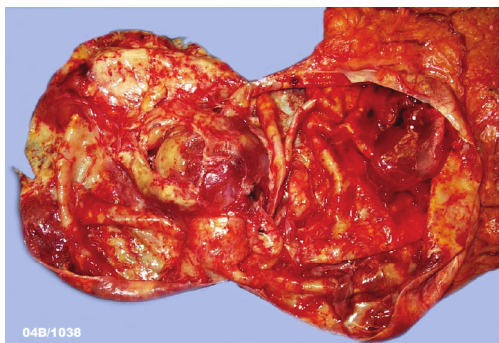
Figure 4: Macroscopically, a large unilocular cystic tumor with a smooth outer surface and several membranous septa projecting in the lumen was